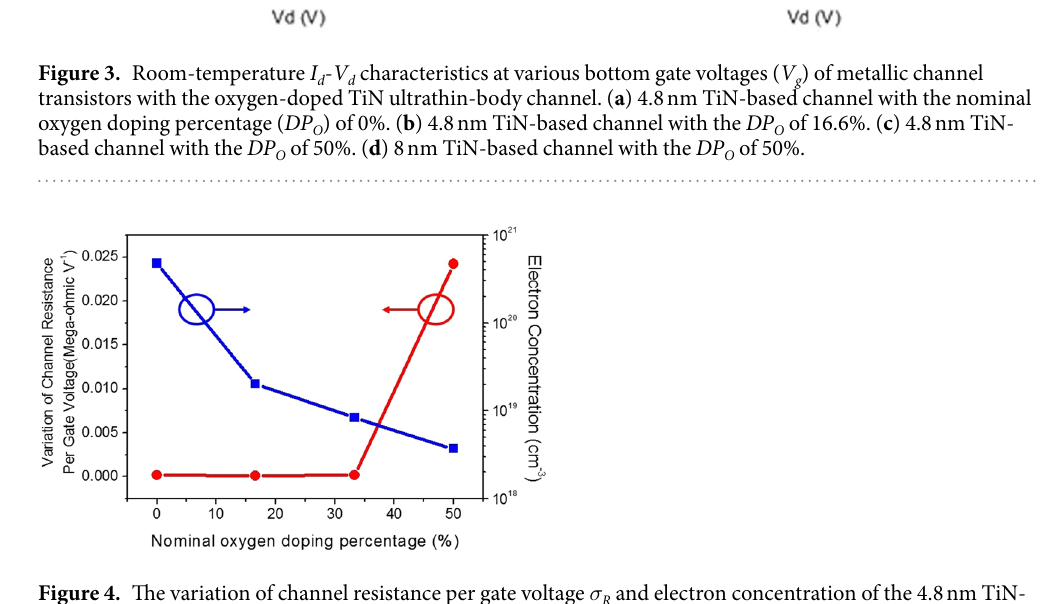
Fig. 3(c). Notice that this electron concentration of 3.7 × 10 18 cm − 3 is closed to that used in the Si JLTs 1, 18, 21 . Here we define the variation of channel resistance per gate voltage as follows: